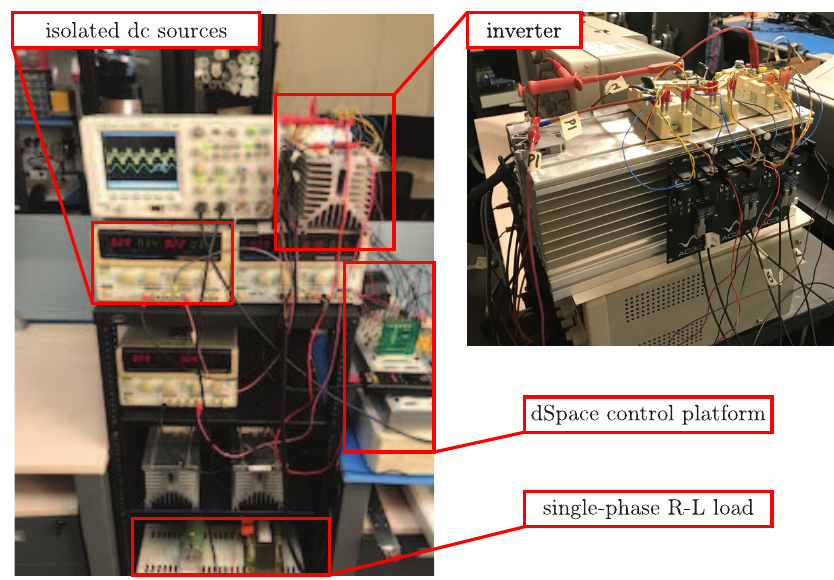
Figure 12. Experimental setup of the 4L-QN inverter. Experimental validation considered three different current references, selected in order to show the inverter performance when operating within linear modulation region and in over-modulation zone. In Figure 13a,b, output voltage and current waveforms are shown for a reference modulation index within linear modulation